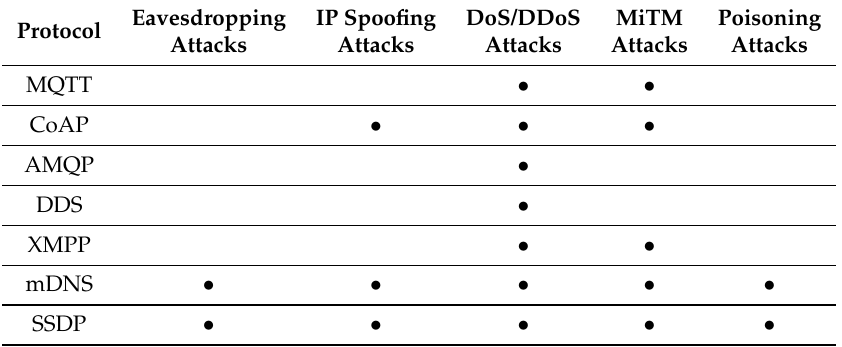
Table 5. Summary of the major attacks affecting the application layer protocols analyzed in this